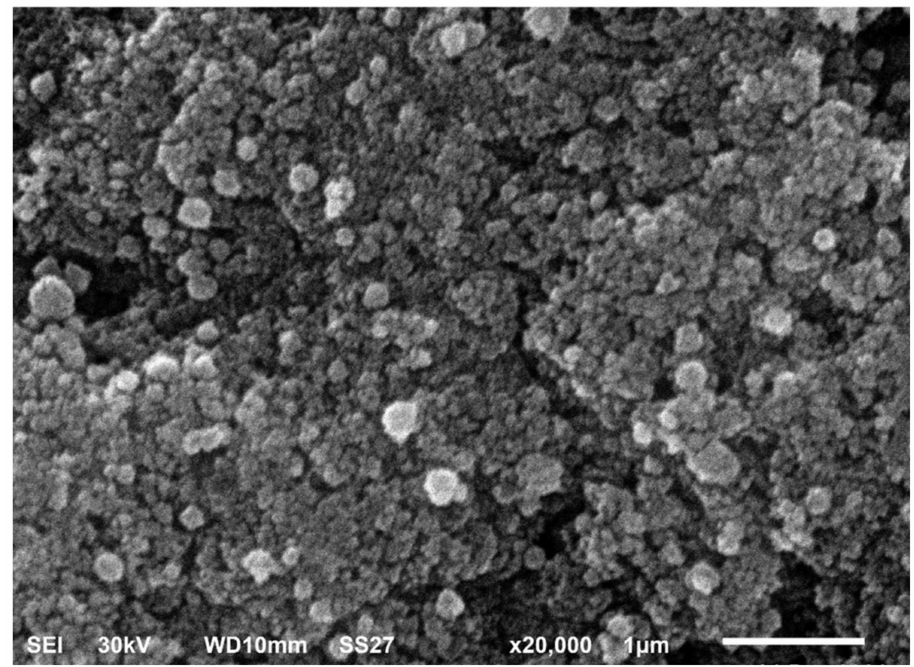
Figure 7. SEM of AgNPs biosynthesized using